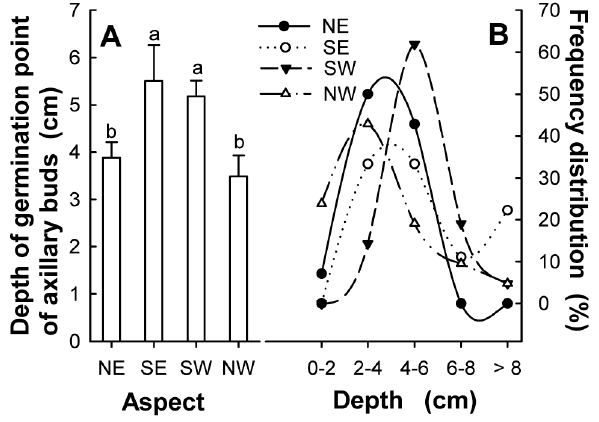
Figure 1. Depth of axillary bud germination points of Nitraria tangutorum and their frequency distribution. Treatments with different letters are significantly different (p , 0.05) according to a one- way ANOVA with aspect as the factor. Error bars represent standard errors of the means.